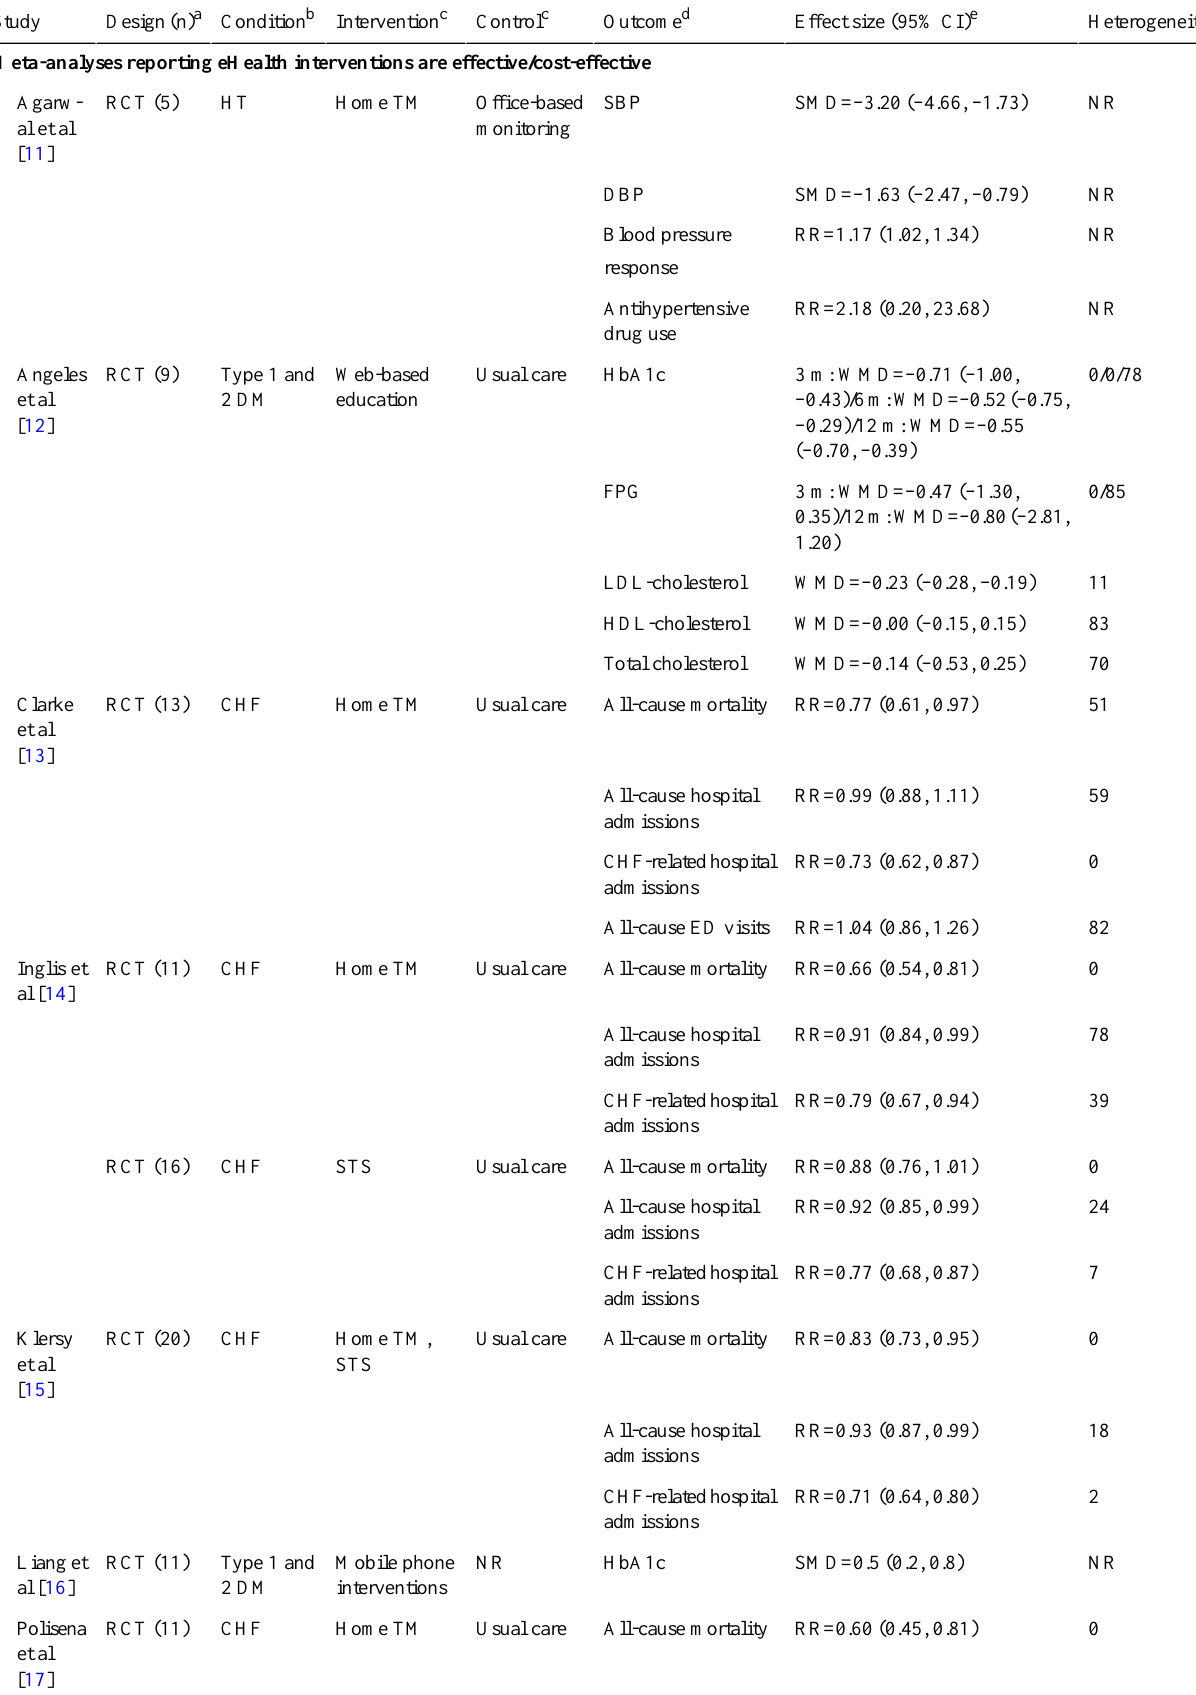
Table 6. Characteristics of 14 systematic reviews in which a meta-analysis was